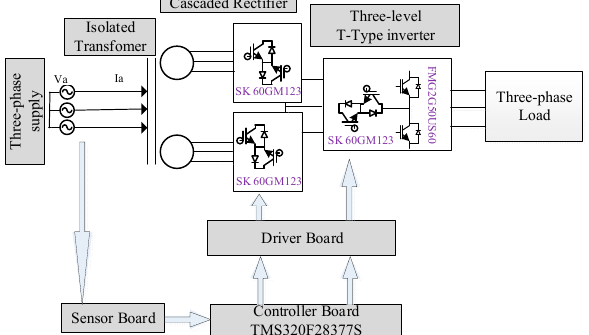
Figure 11. Block diagram of the multilevel IMC hardware experiment.